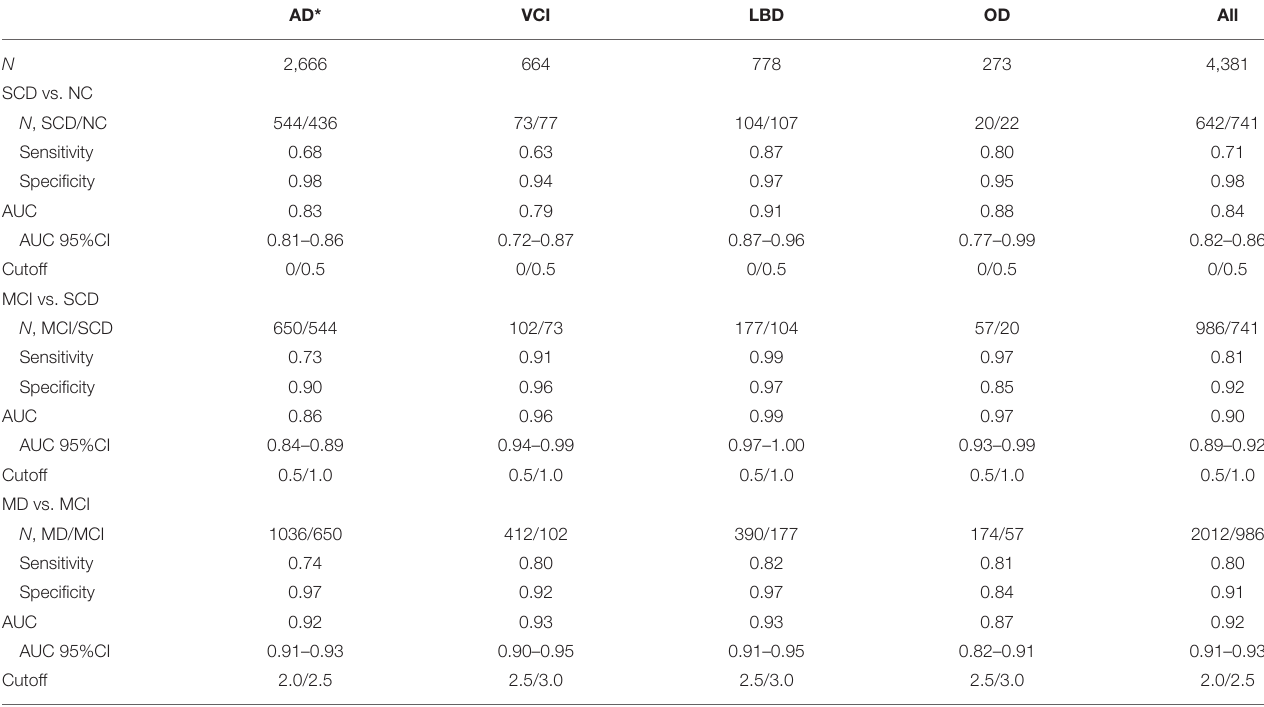
TABLE 3 | Comparison of sensitivity, specificity, area under the curve (AUC), and cutoff score among participants with Alzheimer’s disease*, vascular cognitive impairment, Lewy body disease, other disorders, and all participants with a sum of boxes of the clinical dementia rating scale in the test phase. AD* VCI LBD OD All